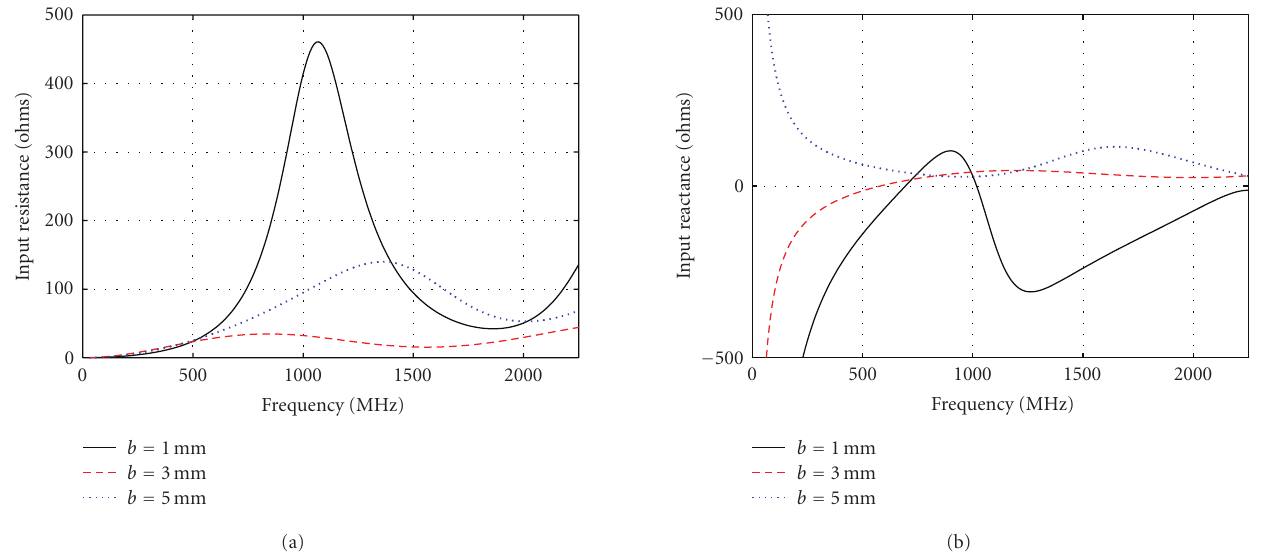
Figure 10: E ff ect of DNG shell thickness b on antenna input impedance. Other parameters: L = 200mm, a = 0 . 3175 mm, r = 0 . 3175 mm, = − 1, and N = ε r = μ r